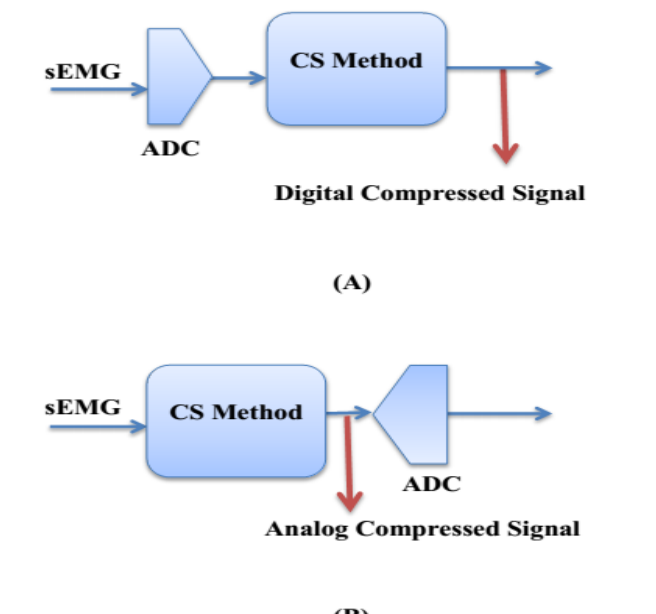
Figure 1. CS scenarios: ( A ) Digital ( B )